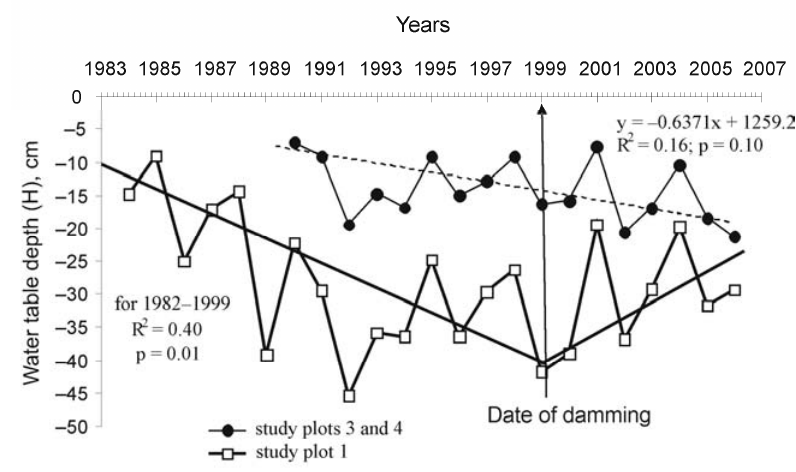
Fig. 2. Variation in water table depth during the growth period (May to October) in the intensively drained and dammed site (study plot 1, the line marked with open squares) and in the naturally developing part (control study plots 3 and 4, marked with filled cycles) during